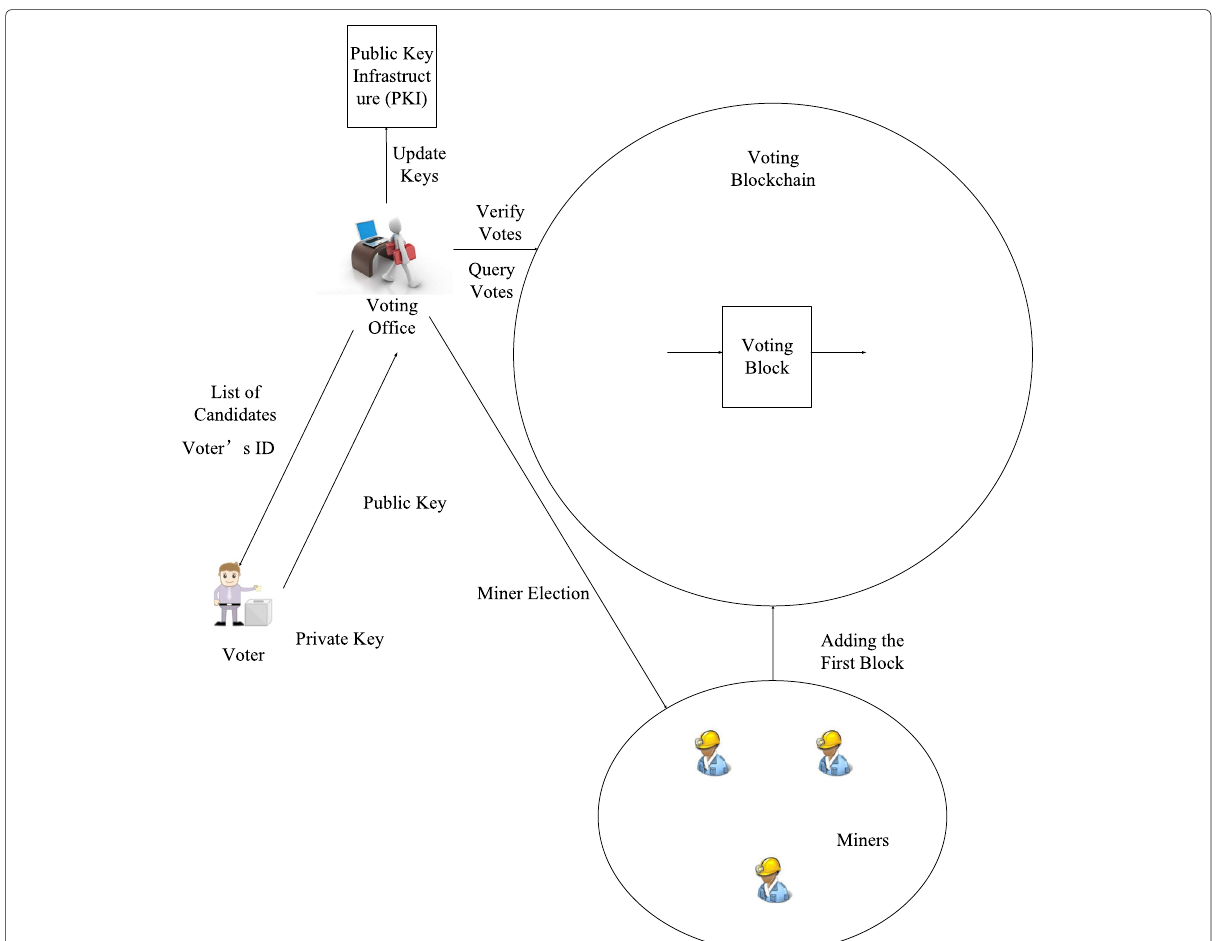
Fig. 6 Initialization of the e-voting